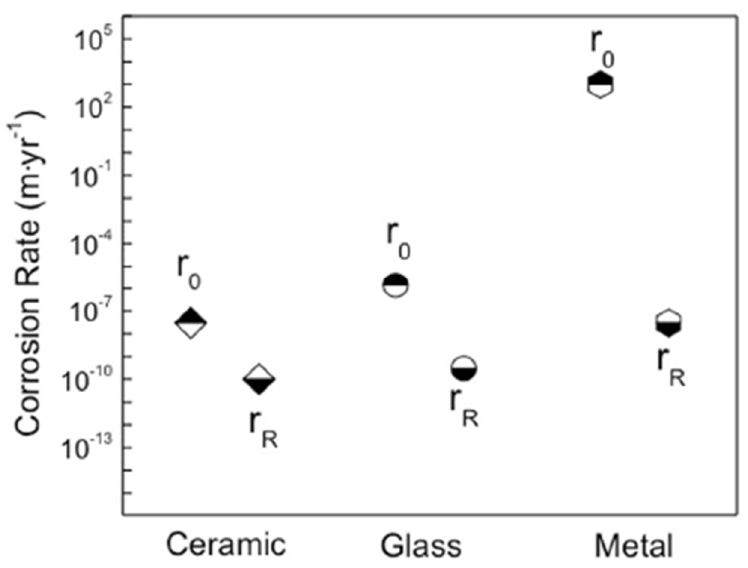
Figure 7. Estimates of corrosion rates of glasses, ceramics, and metal alloys depicting the initial ( r 0 ) and steady state ( r r ) rates. Reproduced from open access reference [33], courtesy of John Vienna, PNNL.